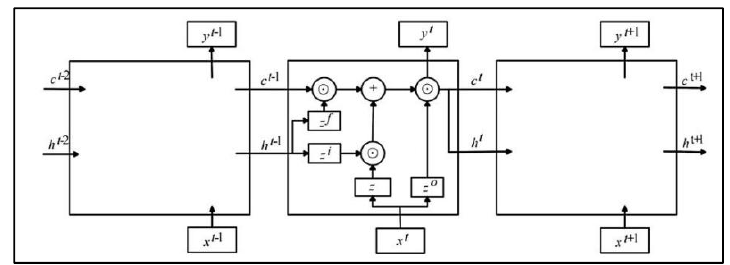
Figure 2. LSTM neural network structure.